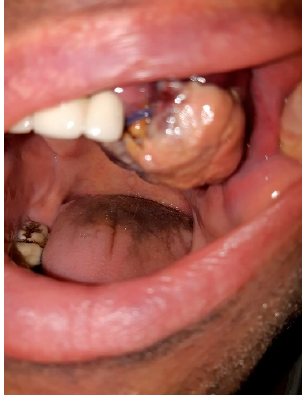
Figure 1. Ulcer-vegetative tumor lesion in the oral cavity. Laboratory tests showed anemia (Hb: 10.2 g/L, n = 12.6–17.4 g/L), leukopenia with lymphopenia (WBC: 4.1 × 10 9 /L, n = 4–10 × 10 9 /L; Ly: 1.1 × 10 9 /L, n = 1–4 × 10 9 /L), modi- fied inflammatory samples (ESR: 58 mm/h, n = 3–9 mm/h; Fb: 474 mg/dl, n = 196–372 mg/dl; CRP: 0.970 mg/L, n = 0–5 mg/L), serological markers for hepatitis B and C negative (AgHBs: negative; anti-HBc: negative; Ac anti-HCV: negative), positive HIV test, IgG